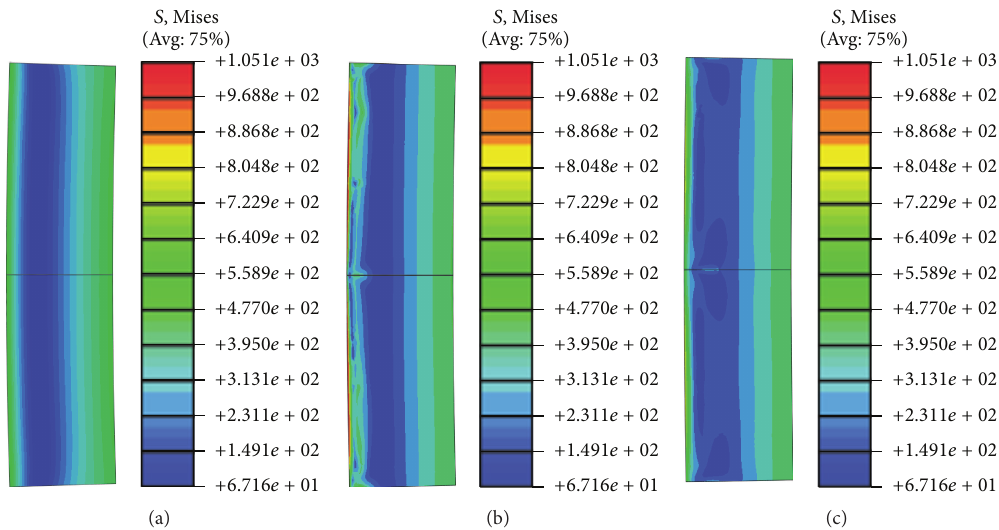
Figure 10: Contour plots of the distributions of Mises stress: (a) under heating and ((b) and (c)) due to cooling at a moment of a small period of time after the beginning and at the end of transient